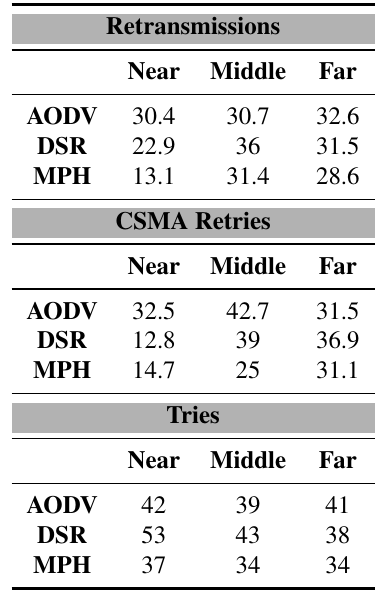
Table 3. Sum of the values of differences for Figures